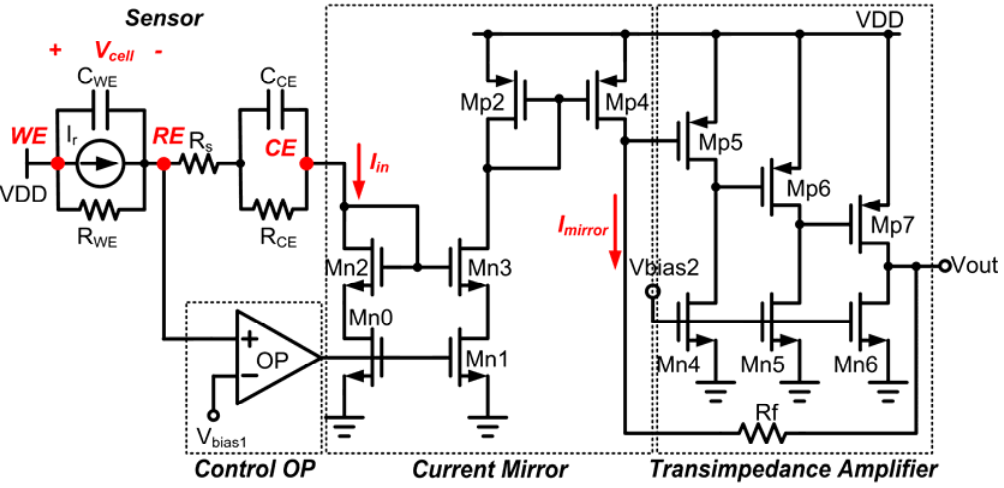
Figure 4. The transistor level of the single-ended